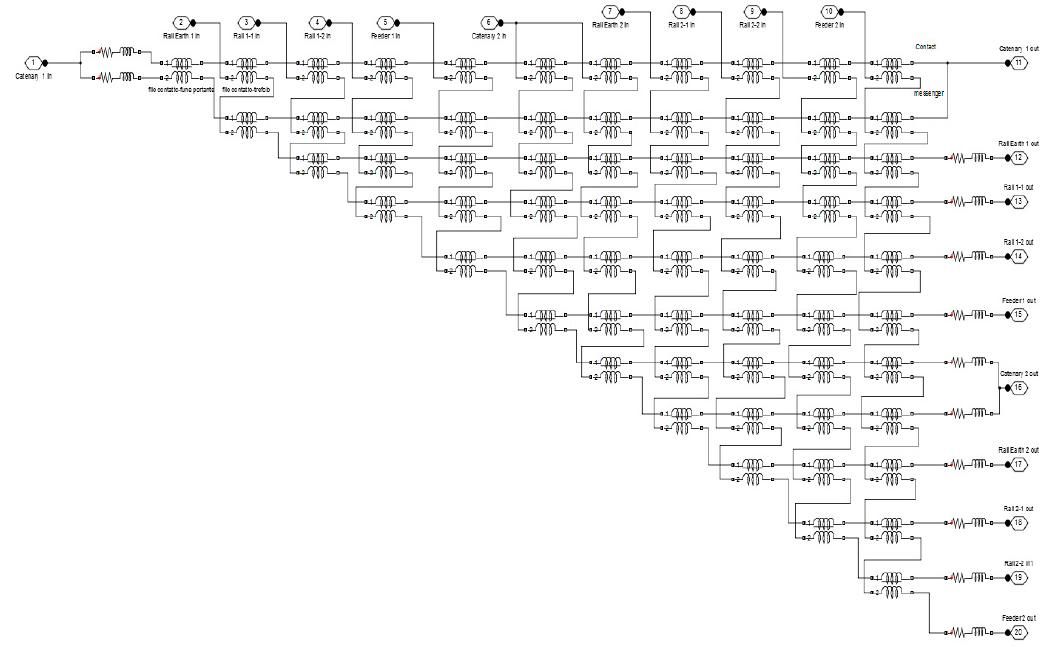
Figure 4. Electric model of the line including all mutual coupling among live and earthling conductors.